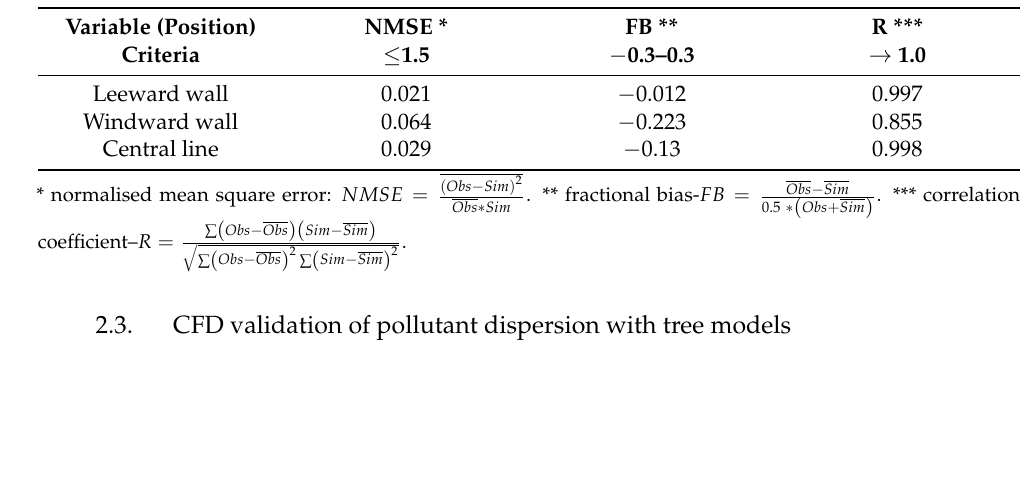
Figure A2. Validation for pollutant dispersion. ( a ) Configurations of the wind tunnel experiment with top view. ( b ) Configurations of the wind tunnel experiment with lateral view. ( c ) Vertical profiles of normalized inert gas concentration K at the roof top of the model. ( d ) Vertical profiles of K at the leeward and windward wall. Table A3. Statistical analysis between wind tunnel data and CFD simulation results—dispersion